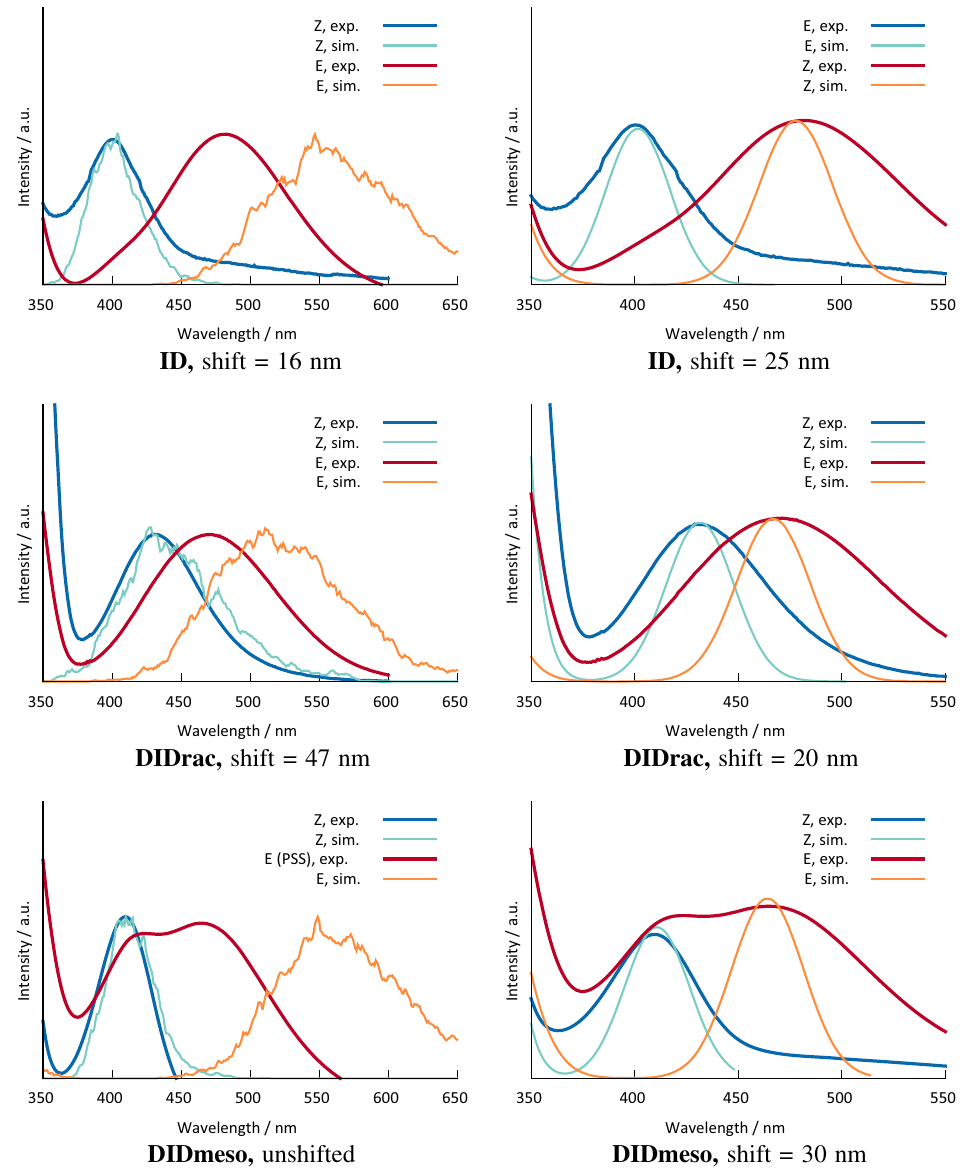
Figure 3. Comparison of the FOCI-AM1 (left) UV spectra and shifted RI-CC2 (right) convoluted vertical excitation energies against the experimental UV spectra for each compound. The shift amount was chosen so that the n ! p (cid:2) bands of the simulated and experimental spectra for the Z isomers showed good